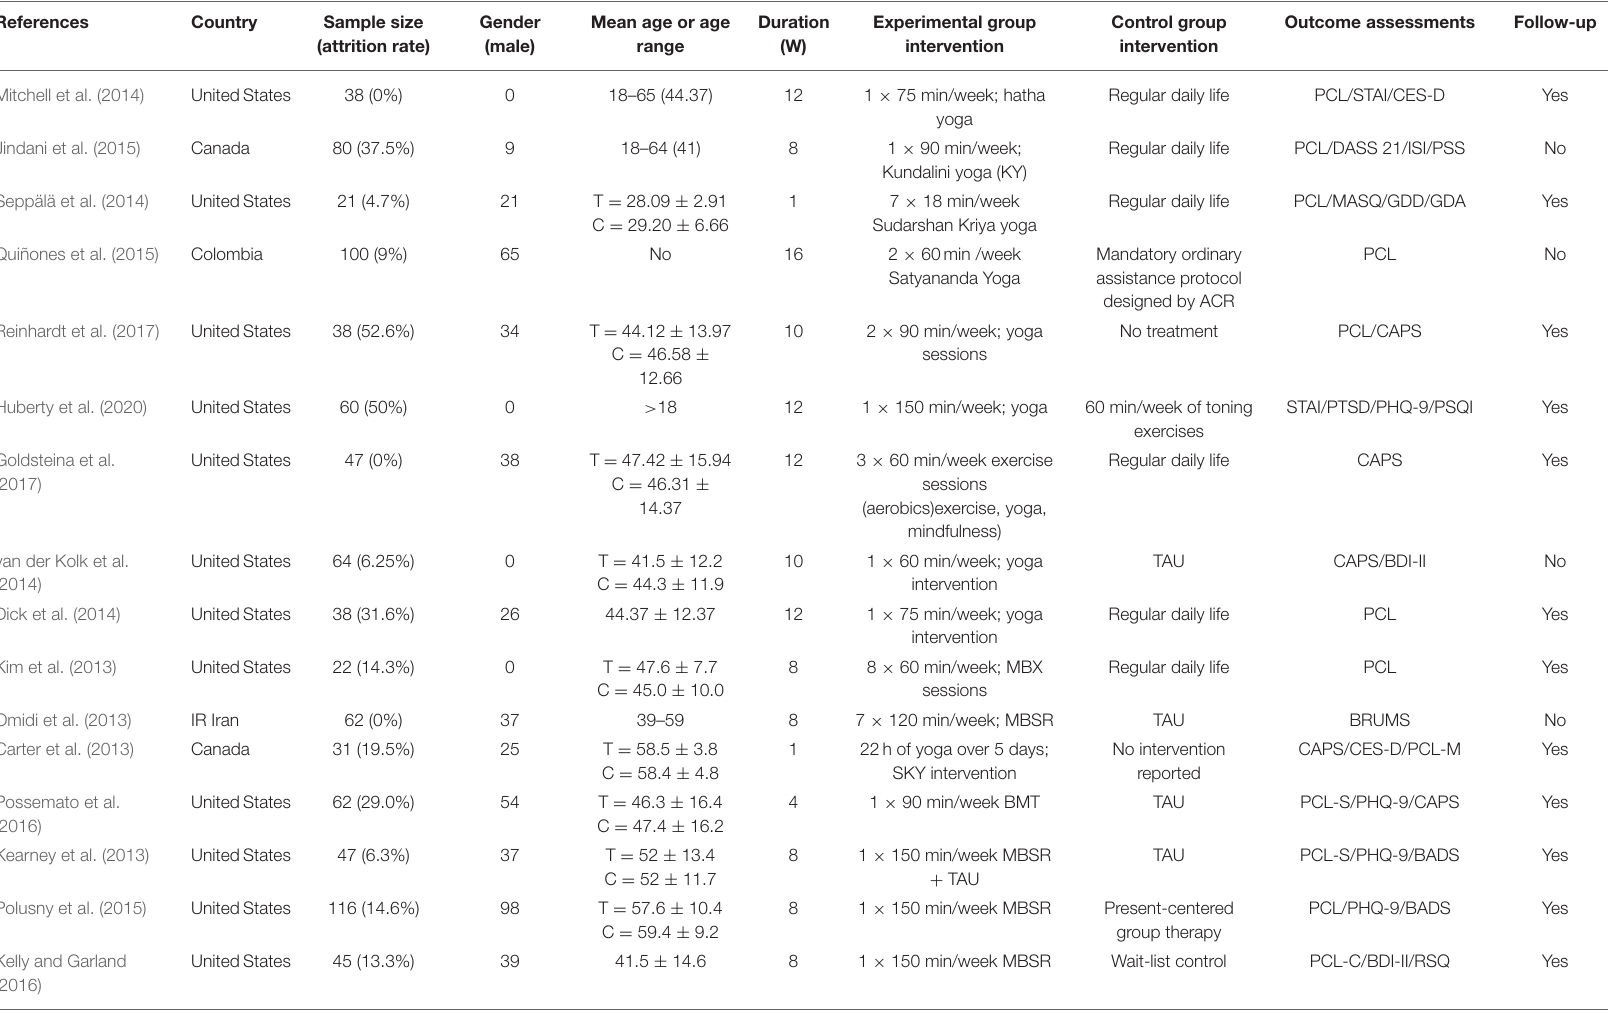
TABLE 1 | Summary of the characteristics of the included